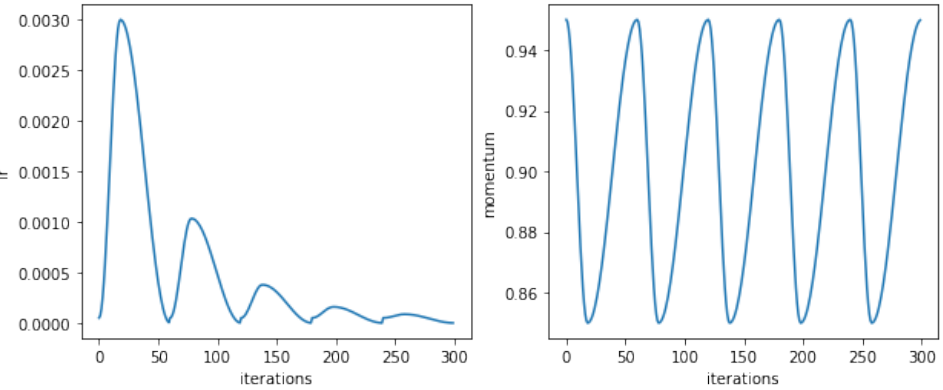
Figure 8. Test run of the learning rate schedule with five cycles produced by a software tool available from [73].